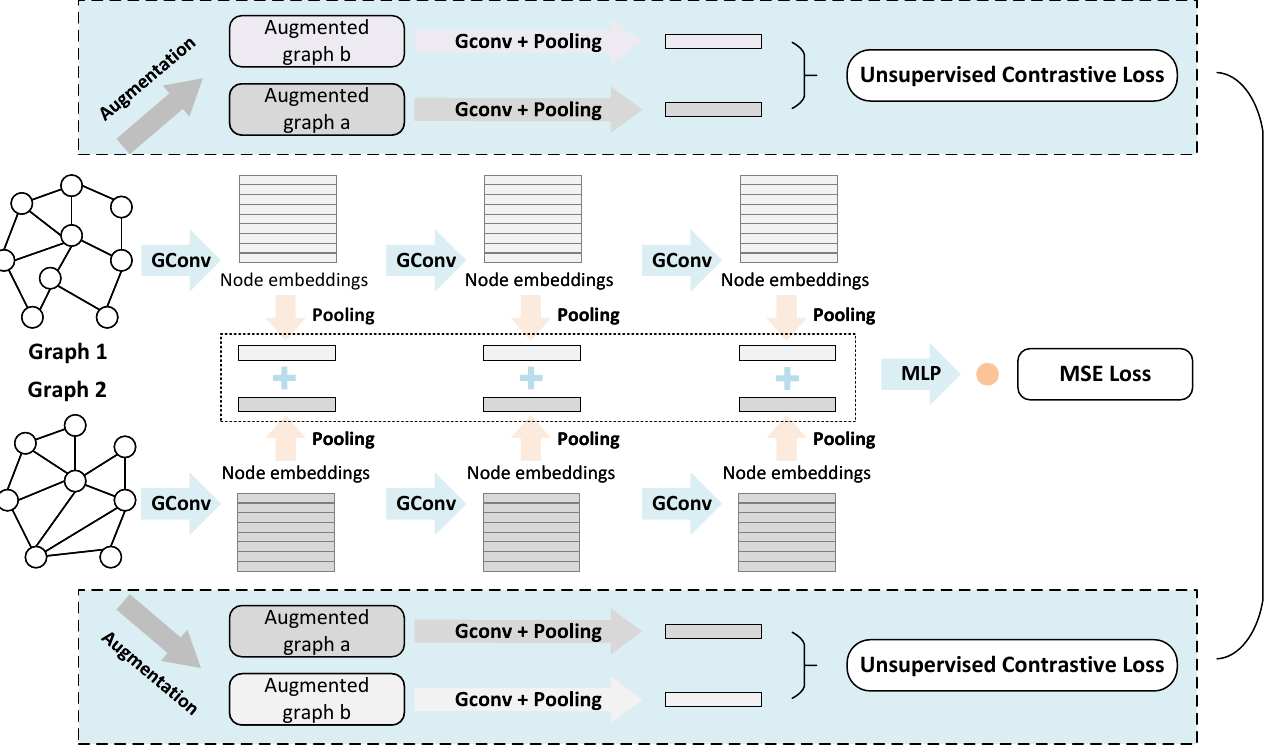
Figure 2. The framework of our proposed model. Given two graphs, they are first fed to the graph similarity prediction network to predict similarity score, which is contrasted with the ground-truth label to produced the MSE loss. Additionally, each graph is processed by the contrastive learning model to produce the unsupervised contrastive loss. These losses are aggregated and used to train the proposed